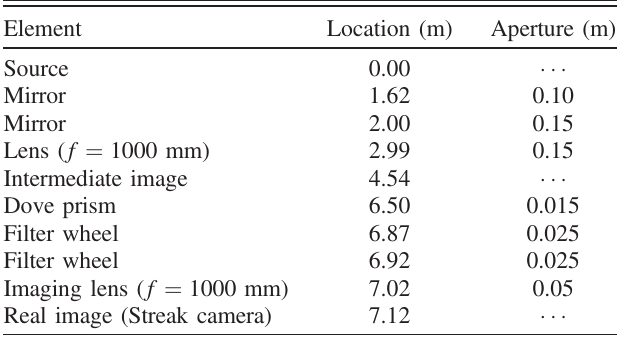
TABLE III. Optical Elements in the Streak Camera